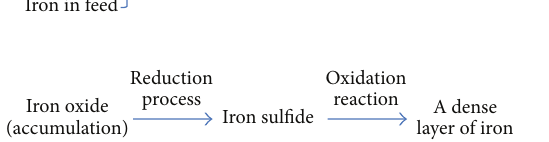
Figure 7: Iron poisoning process.